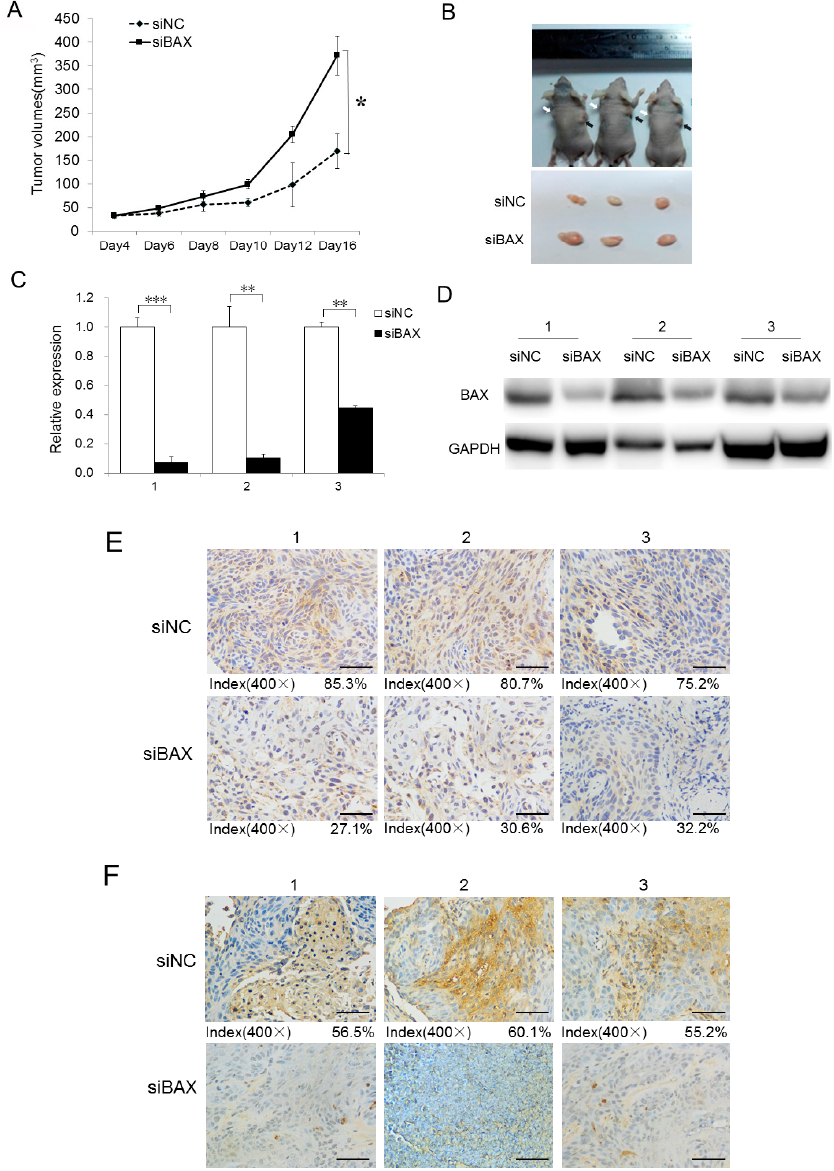
Figure 4. BAX knockdown by siRNA mimics promotes tumor growth in vivo. siNC and siBAX oligos were injected into A431 cell xenografts every three days. ( A ) Loss of BAX promotes subcutaneous tumor growth in a mouse xenograft model. Tumor volumes (mm 3 ) were plotted according to days. Tumor volume statistical data represent the average of three independent experiments ± s.d., respectively; ( B ) the mice were sacrificed at the end of the experiment and images taken along with the dissected tumors from three representative mice are shown. White arrows indicate the siNC-treated xenografts, while black arrows indicate siBAX-treated xenografts; ( C ) the expression of BAX was measured in the dissected tumors by qRT-PCR. qRT-PCR statistical data represent the average of three independent experiments ± s.d. Expression folds are shown with respect to NC where normalized copy numbers were set to 1; ( D ) the protein expression of BAX was detected in xenografts after siBAX treatment by Western blot; ( E ) histopathology analysis (IHC staining) of BAX on tumor sections. The quantification was done by counting positively-stained cells from 20 randomly-chosen fields from a total of five ections per tumor. Magnification, 400 × , Scale bars, 50 µ m; ( F ) TUNEL assay of apoptosis on tumor sections after BAX depletion. The quantification was done by counting positively-stained signals from 20 randomly-chosen fields from a total of five sections per tumor. Magnification, 400 × , Scale bars, 50 µ m. ** p < 0.01, *** p <